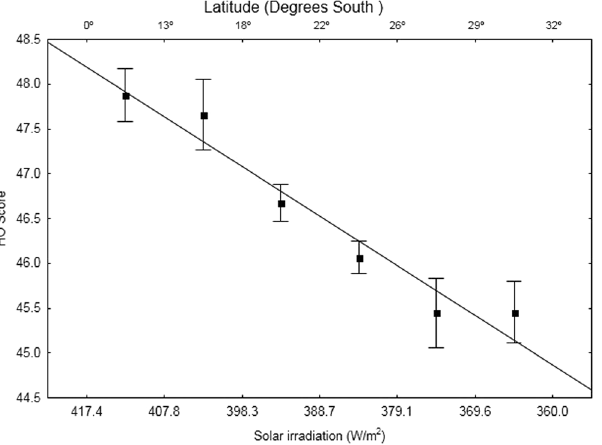
Figure 2. Mean HO scores ( ± SE) along a latitudinal cline, showing corresponding annual average of solar irradiation level (W/m 2 ).